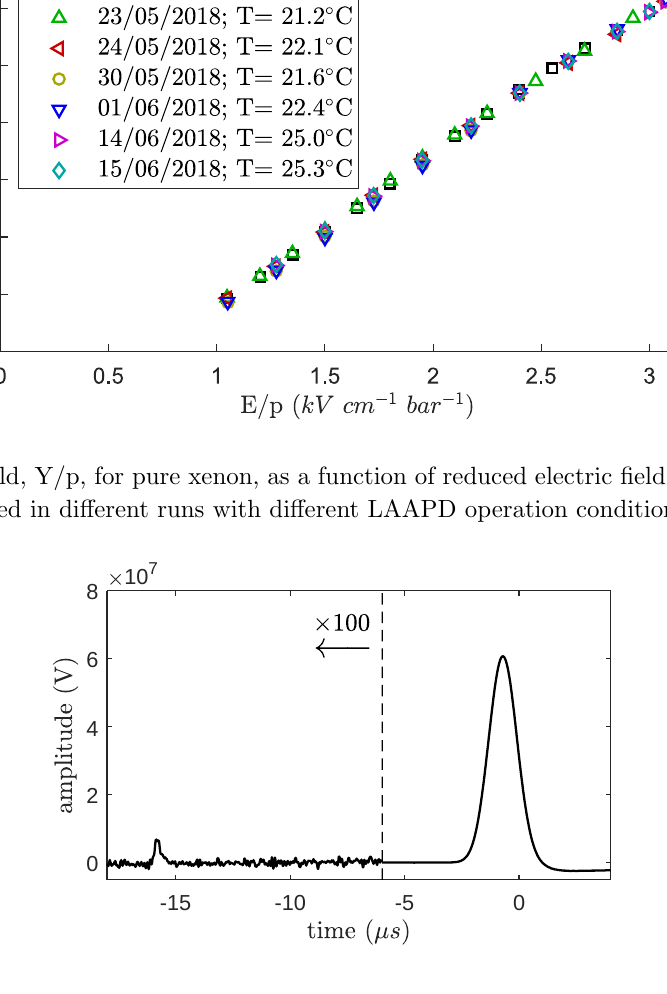
Figure 6 . Typical average waveform produced by alpha particles (a few tens of Hz) in pure xenon at 1.1 bar, for a mean reduced electric (cid:12)eld of 376 V/cm/bar in the drift region, and a reduced electric (cid:12)eld of 2.7 kV/cm/bar in the EL